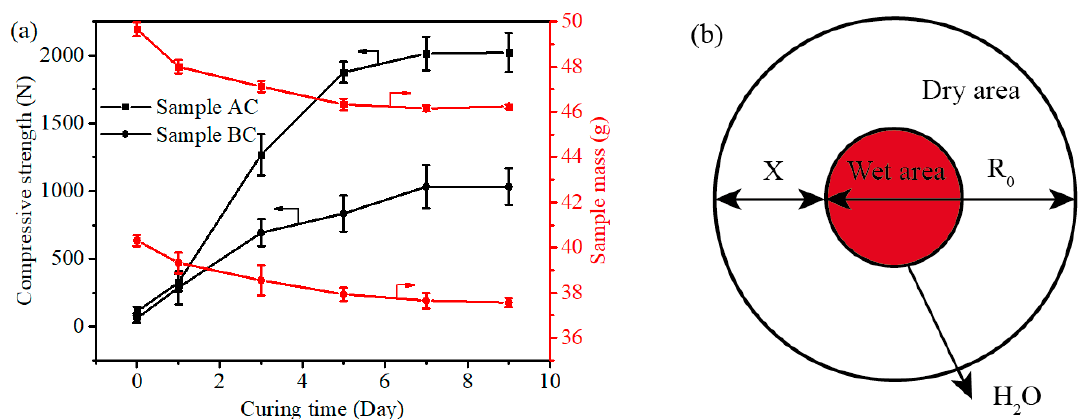
Figure 15. Evolution of compressive strength and the mass of samples AC and BC during the curing process ( a ) and the model of the curing process ( b ).